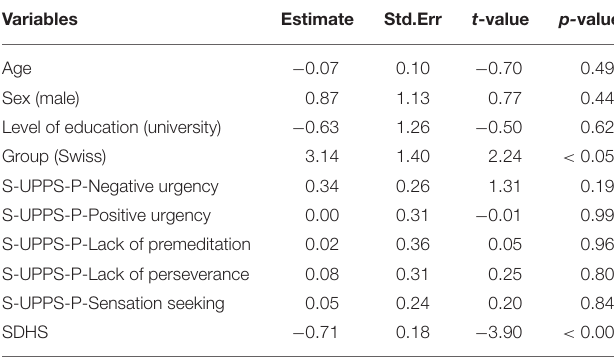
TABLE 3 | Multiple linear regressions by groups on the CIUS total score ( N = 237).